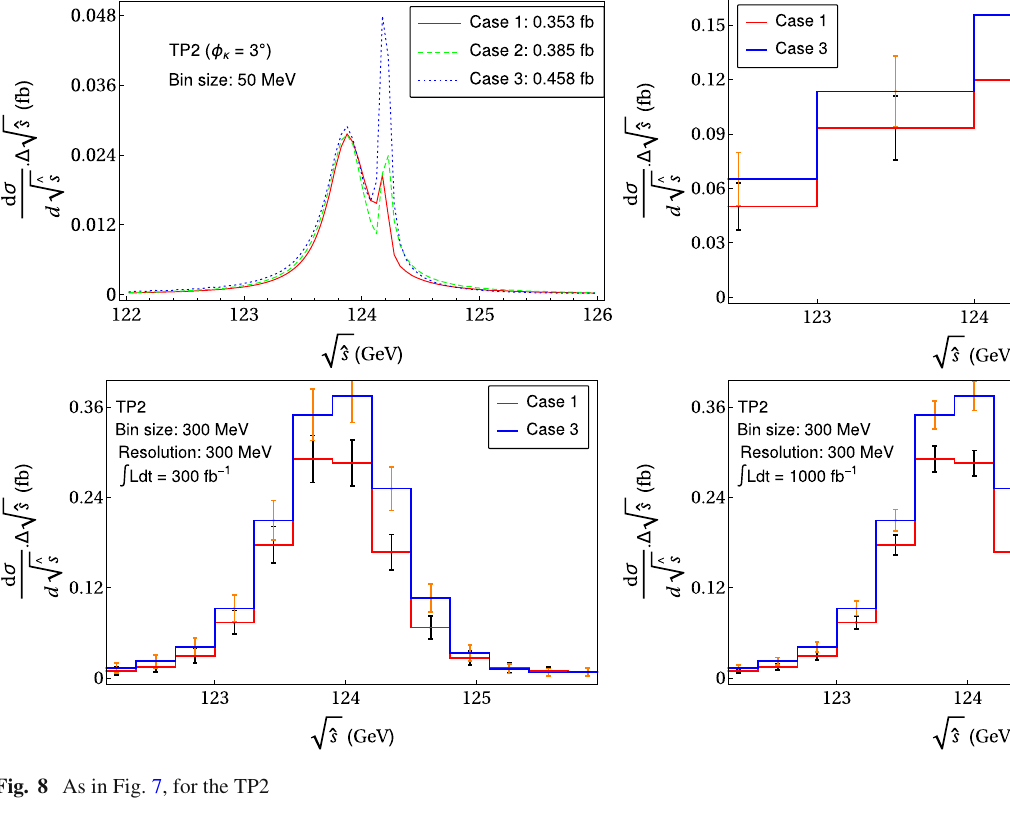
Fig. 8 As in Fig. 7, for the TP2